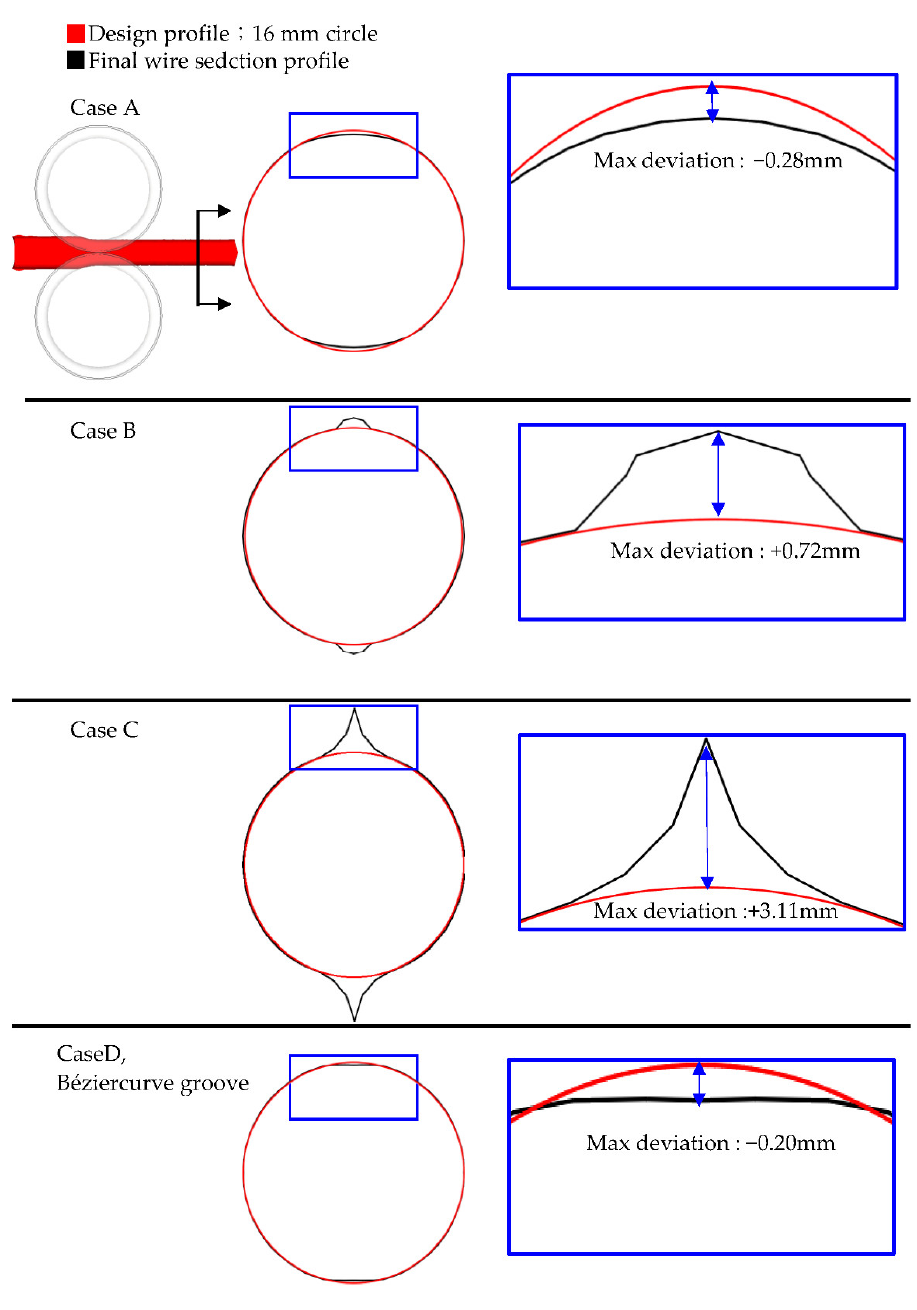
Figure 10. The section profile deviations of the roll-formed wire.